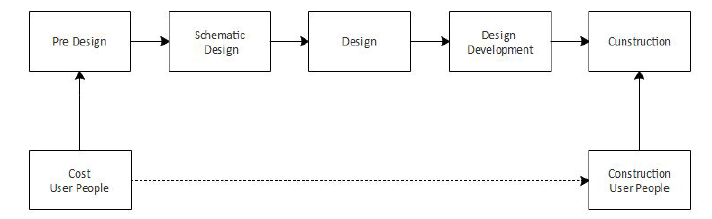
Figure 10. Social mobilization model (source: